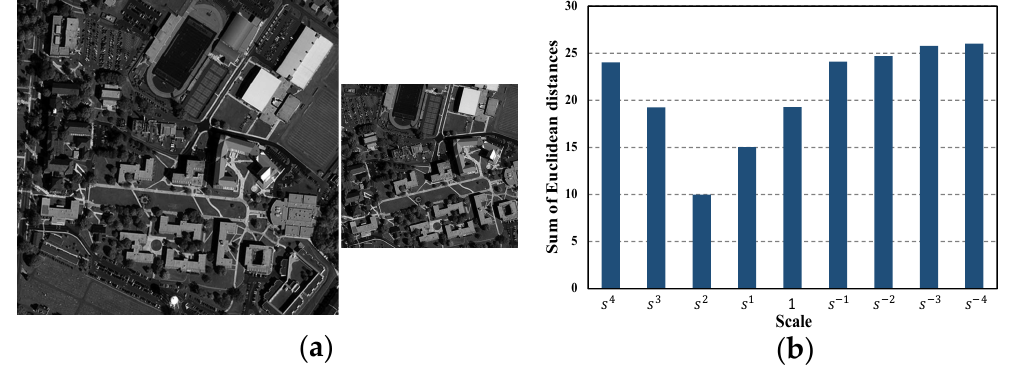
Figure 4. Illustration of scale estimation in image pyramids. ( a ) Test image ( left ) and reference image ( right ); ( b ) Sum of the top 100 least Euclidean distances in nine